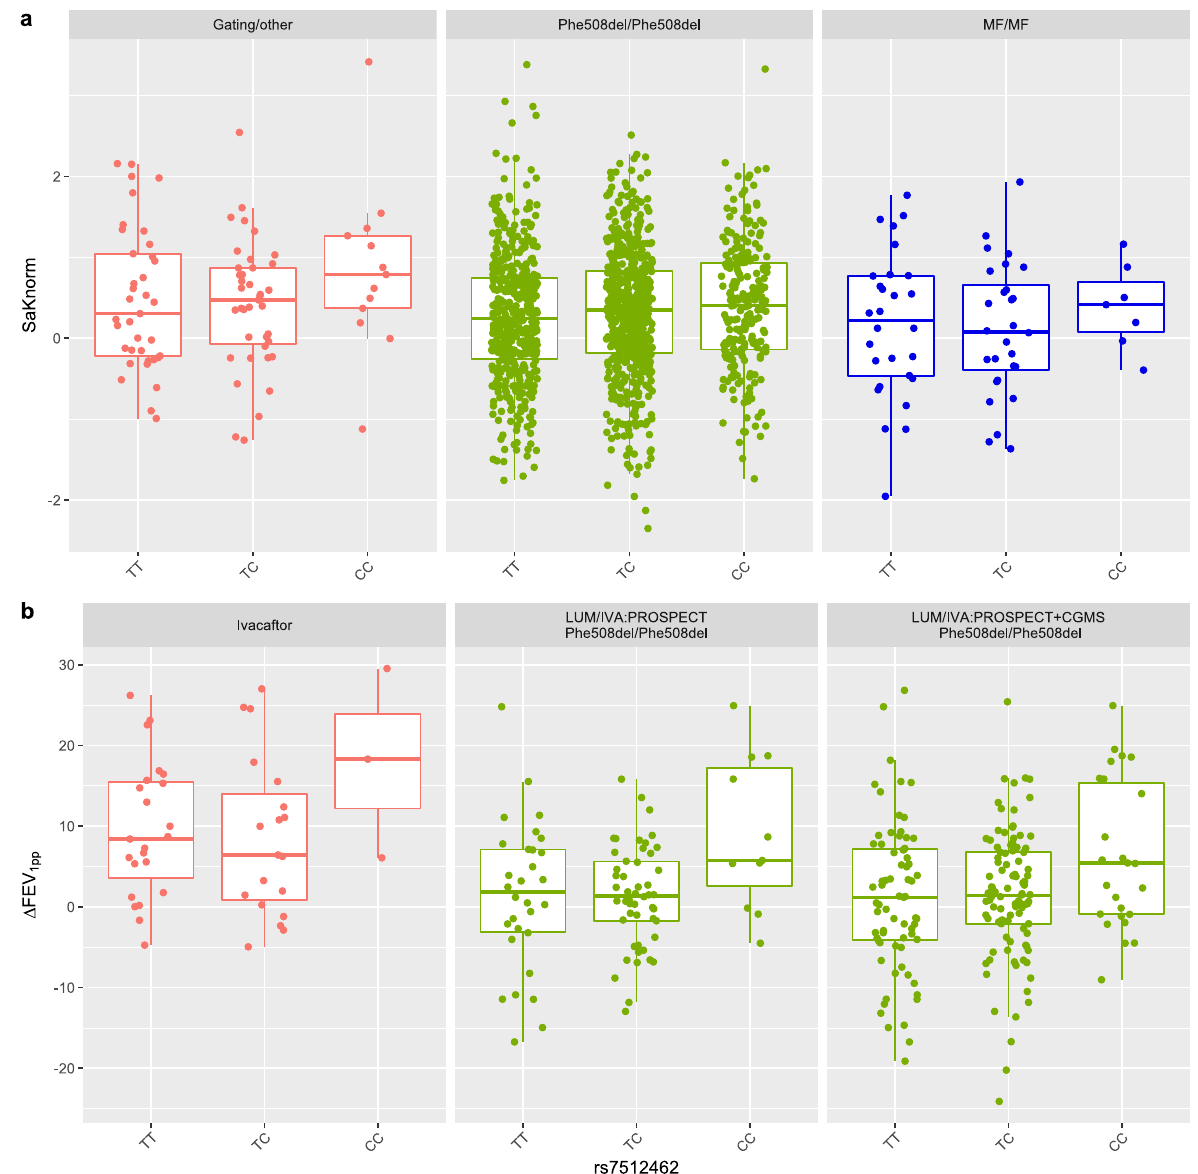
Fig. 2 Participant lung function or lung treatment response categorized by rs7512462 genotype. a Boxplot includes an overlay with a stripchart of lung function from CGMS participants prior to modulator treatment, measured as Saknorm across different CFTR mutation groups. Saknorm 5,35 is calculated with FEV 1 measurements taken prior to modulator treatment, if applicable. b Boxplot includes an overlay with a stripchart for treatment response in patients on IVA ( n = 45), LUM/IVA in PROSPECT cohort ( n = 91) or LUM/IVA in combined PROSPECT and CGMS samples ( n = 195). Following Strug et al. 31 , the treatment response for IVA is de fi ned as the difference between the mean post- treatment FEV 1pp within 15 to 400 days and FEV 1pp baseline. Response for LUM/IVA is de fi ned as the difference in FEV 1pp between the fi rst post treatment within 5 to 7 months to the baseline 65 (Methods). The center line, upper and lower box limits of boxplots correspond to the median, the third quartile (Q3) and the fi rst quartiles (Q1), respectively; whiskers re fl ect the 1.5x interquartile range (IQR), i.e., bottom whisker is Q1-1.5xIQR and upper whisker is Q3 + 1.5 x IQR. Each dot represents an individual